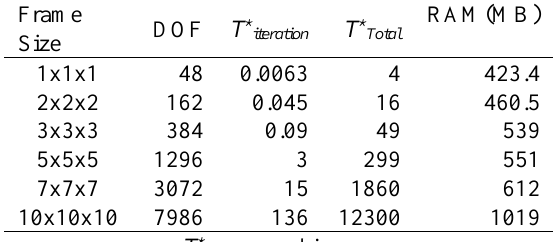
Table 3. Simulation time for different frame sizes